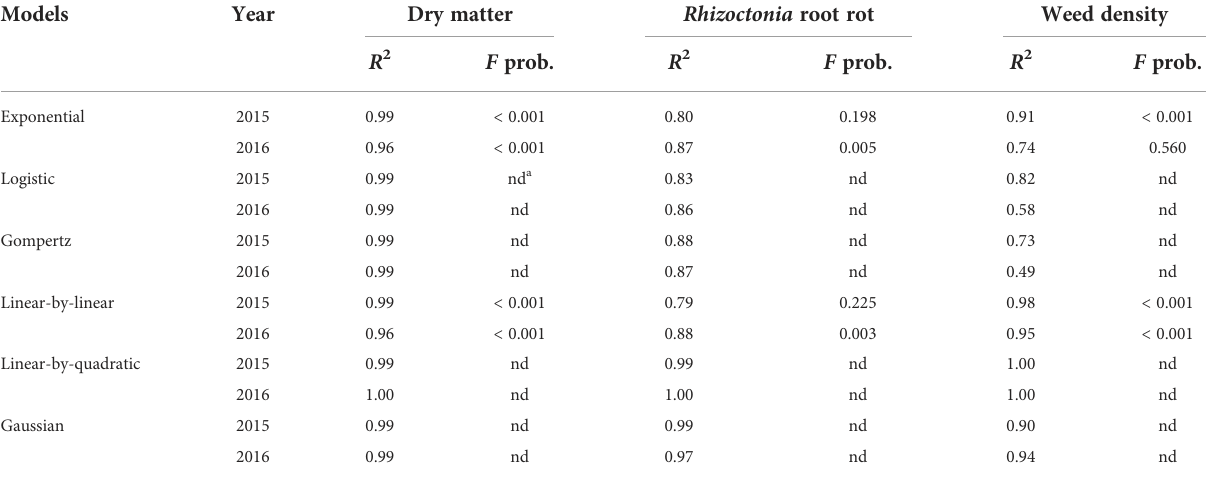
TABLE 1 Standard regression models to characterize development of bean dry matter, Rhizoctonia root rot, and weed density in two bean cultivars grown under different planting date and weed control treatments.